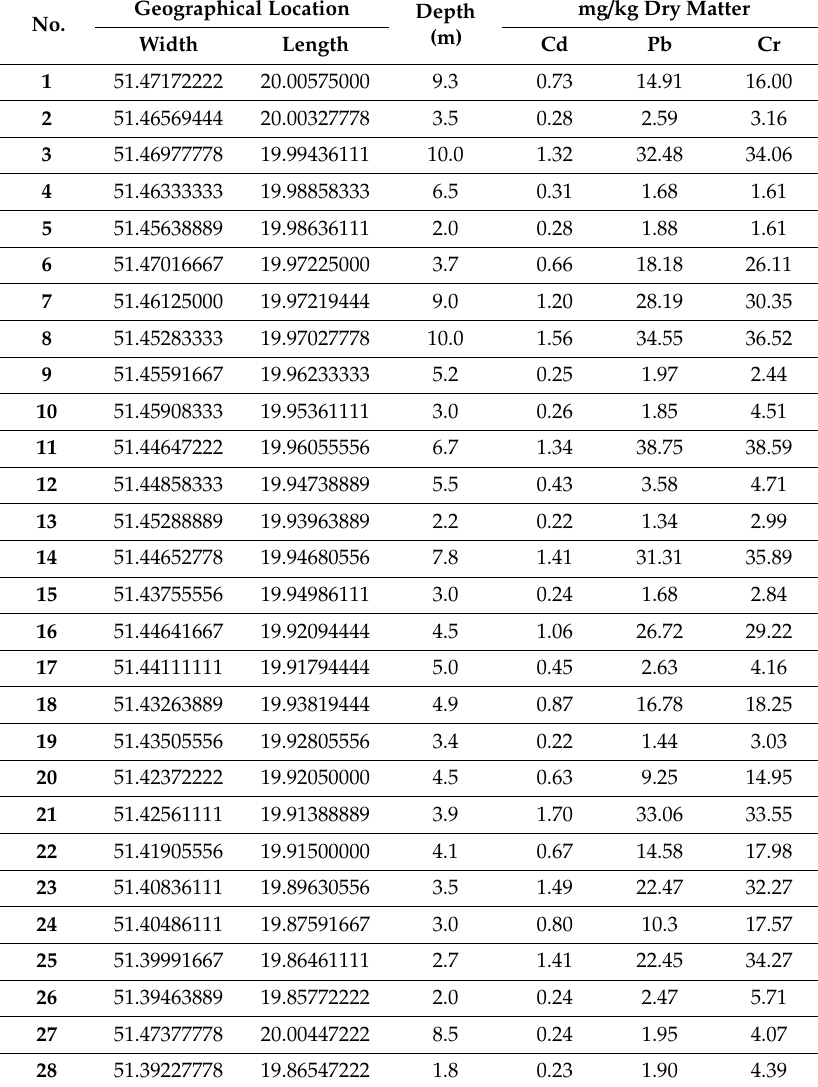
Table 3. Concentration of trace elements in bottom